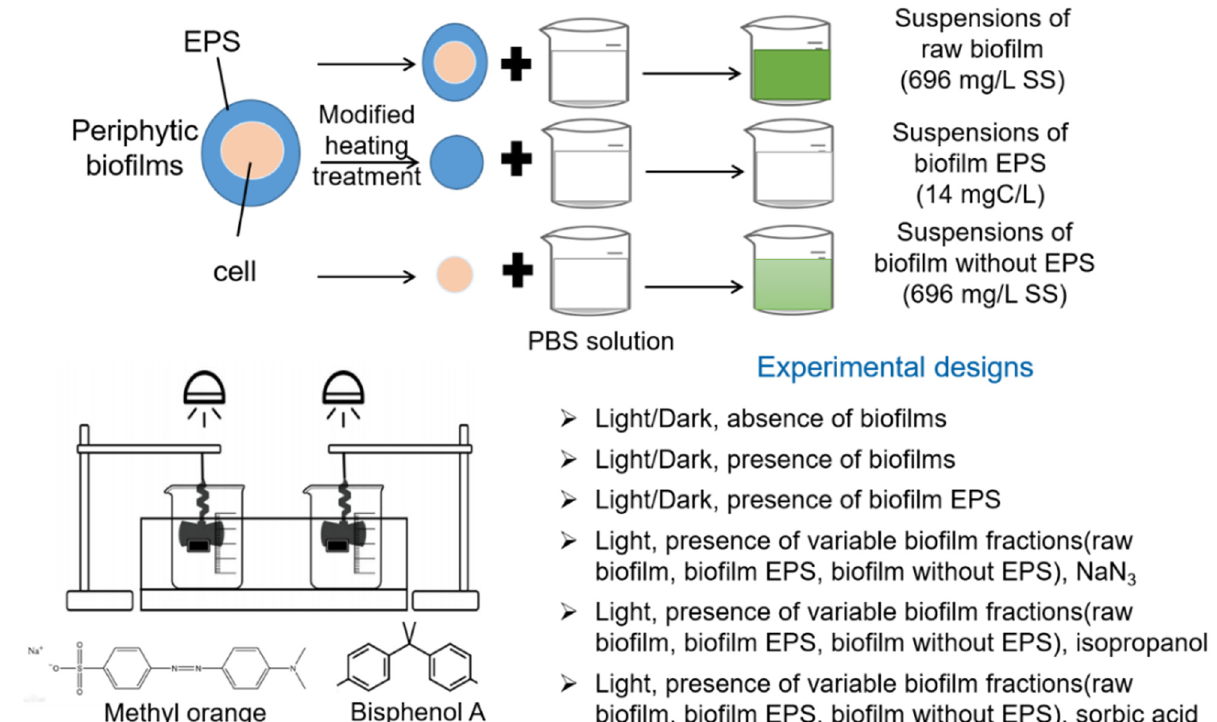
Figure 1. Batch experimental design.